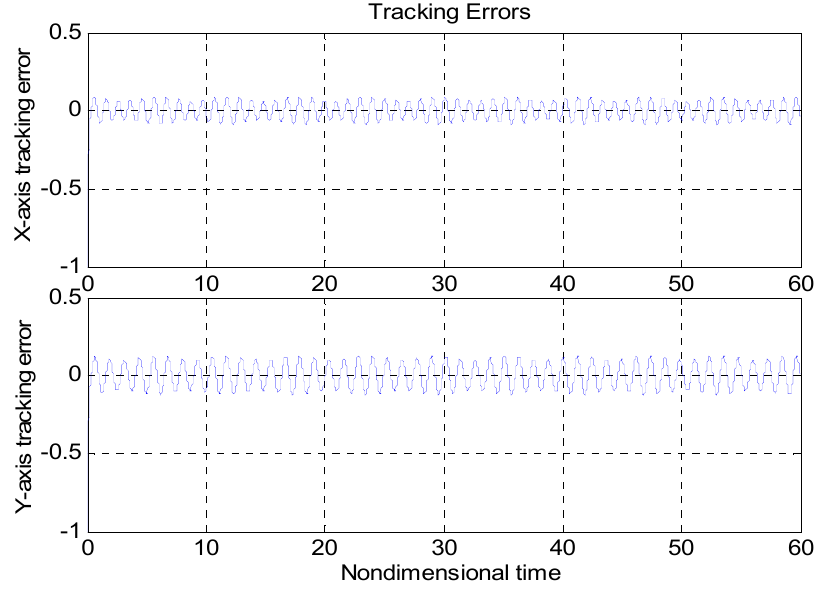
Figure 10. Tracking errors without using a controller. Table 2. Root mean square errors (RMSE) of tracking error in x -axis and y -axis using three